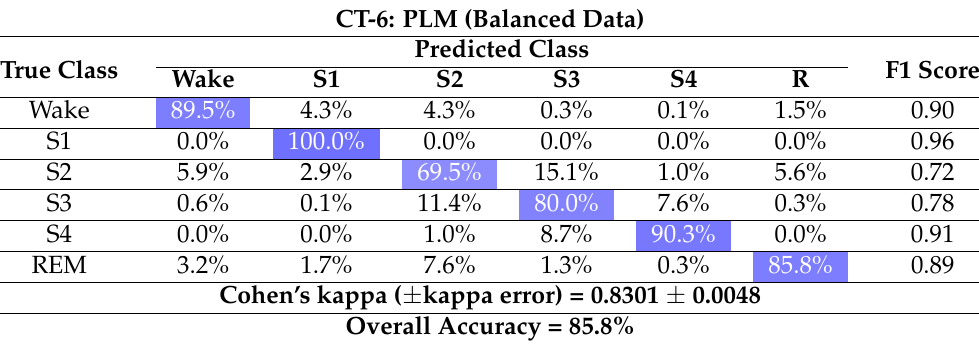
Table 20. Confusion matrix corresponding to sleep stage classification of periodic leg movement patients with balanced data using the EBT classifier with 10-fold CV.